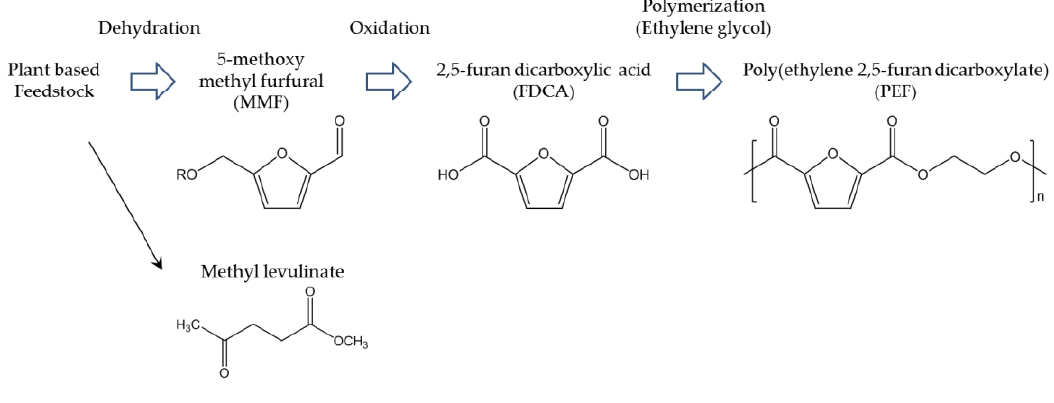
Figure 8. Avantium’s PEF production process [87]. Table 7. Comparison of the physical properties of PEF and PET [88].